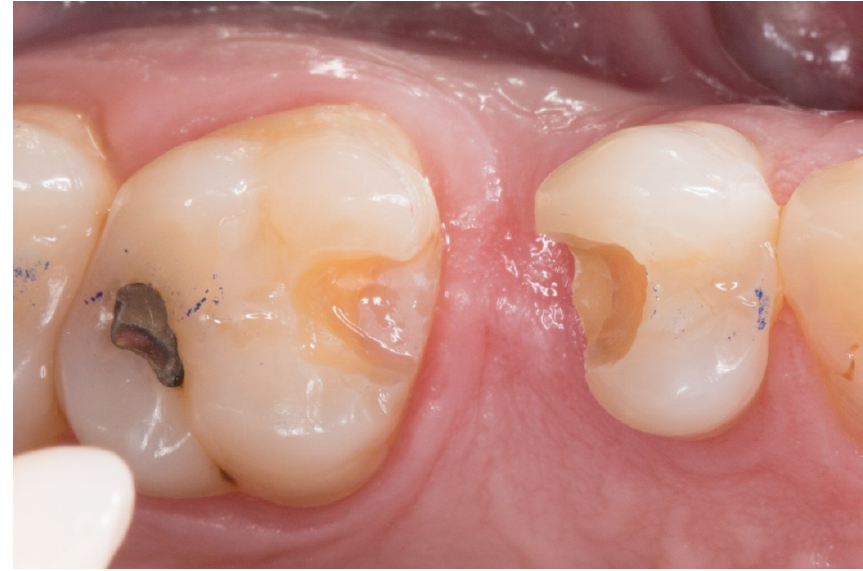
Figure 1. A posterior maxilla edentulous space.